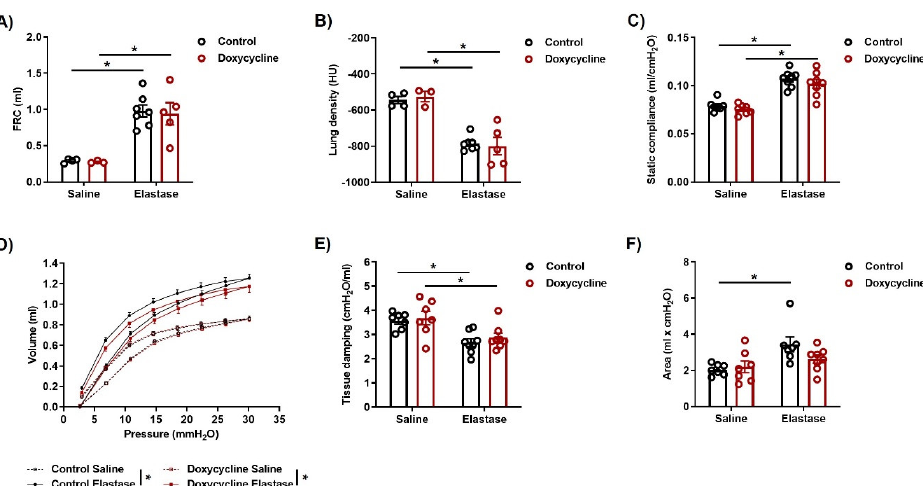
Figure 3. Deletion of iNOS in AECII cannot ameliorate elastase-induced changes in lung function. Two weeks after intratracheal instillation of saline or elastase, iNos CCSP rtTA2 s -M2 LC1 mice were fed with either standard (control) or doxycycline-containing (Doxycycline) chow for additional two weeks. Twelve weeks later, micro-computed tomography ( µ CT) and lung function measurements were performed. ( A , B ) µ CT-based assessment ( n = 3–7) of ( A ) functional residual capacity (FRC) and ( B ) lung density. HU: Hounsfield units. ( C – F ) Lung function (n = 7–8) presented as ( C ) static compliance, ( D ) respiratory pressure-volume (P-V) loops, ( E ) tissue damping, ( F ) area enclosed by the P-V loop. Graphs show mean ± SEM. * p < 0.05. Two-way ANOVA (with Tukey’s multiple comparison post-hoc test) was used.